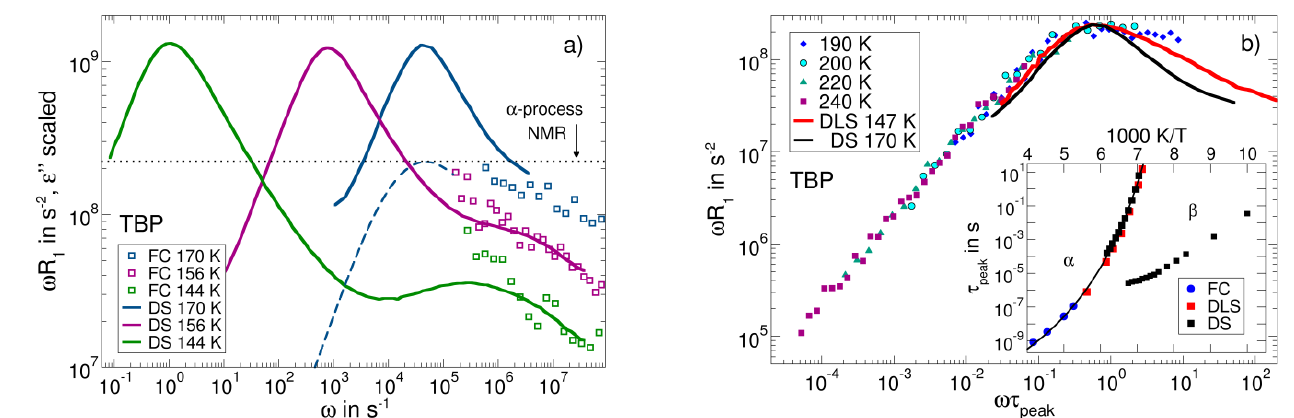
Figure 13. ( a ) Dielectric spectra (DS, solid lines) [143,144] corrected for the Curie factor and scaled in amplitude by a global factor to match the FC 31 P NMR susceptibility (open symbols) of tributyl phosphate (TBP) at the indicated temperatures [53]. The blue dashed line is the interpolated NMR data from panel ( b ) re-scaled with τ α ( T = 170 K). ( b ) Susceptibility master curve of TBP constructed from FC 31 P relaxation data at temperatures from 190 K to 240 K on a reduced frequency scale ωτ peak . A DS spectrum at 170 K [144] and a DLS spectrum at 147 K are included [27], both shifted to the NMR peak. Inset: correlation times of the α - and β -processes from FC 31 P NMR relaxometry, DS [143], and DLS [27]. The black line is a guide for the eye.